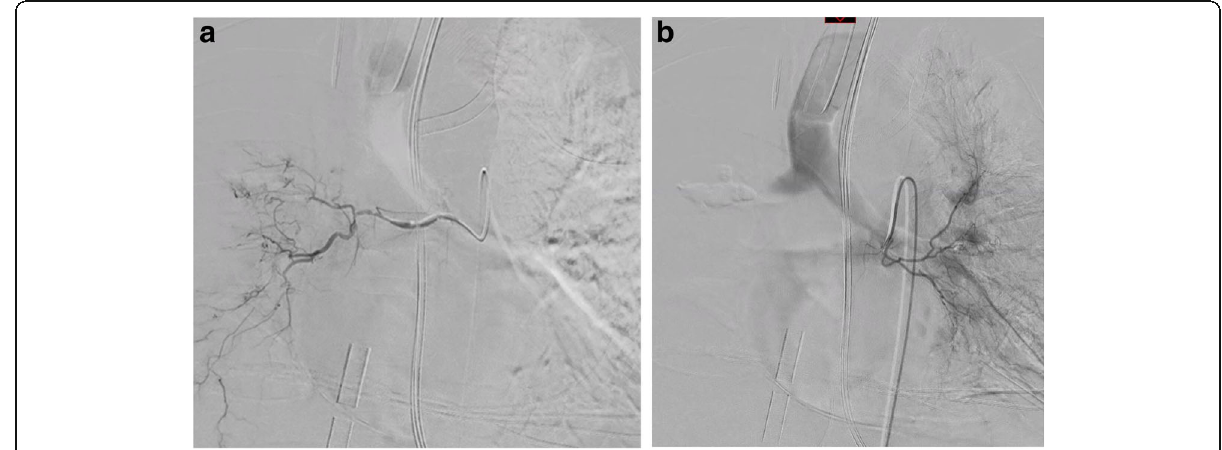
Fig. 3 Arteriography showing normal right ( a ) and left ( b ) bronchial